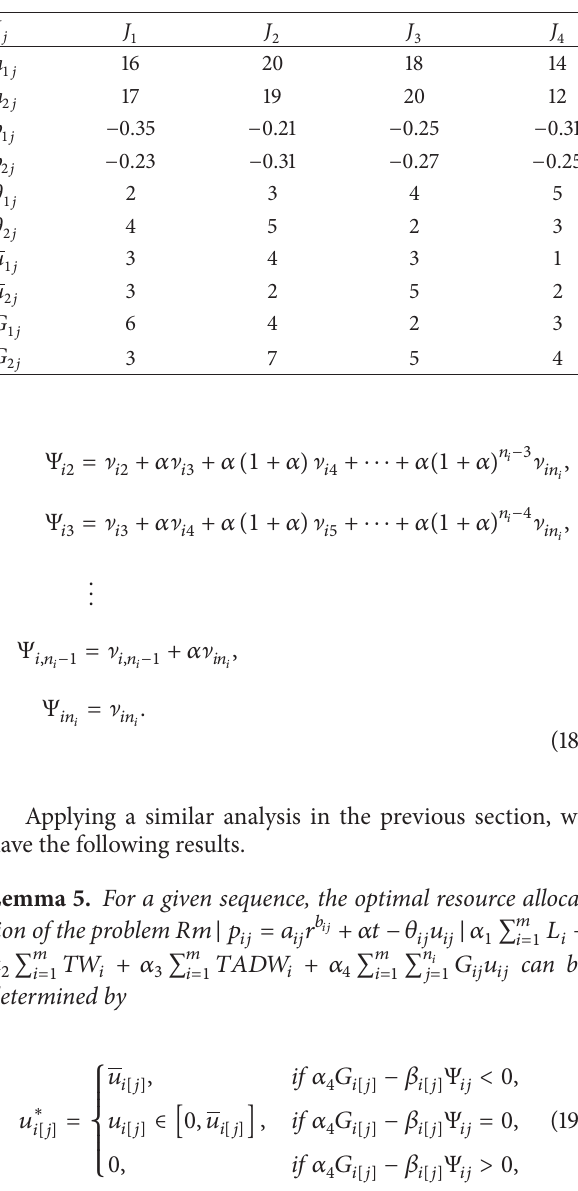
Table 1: The date of Example